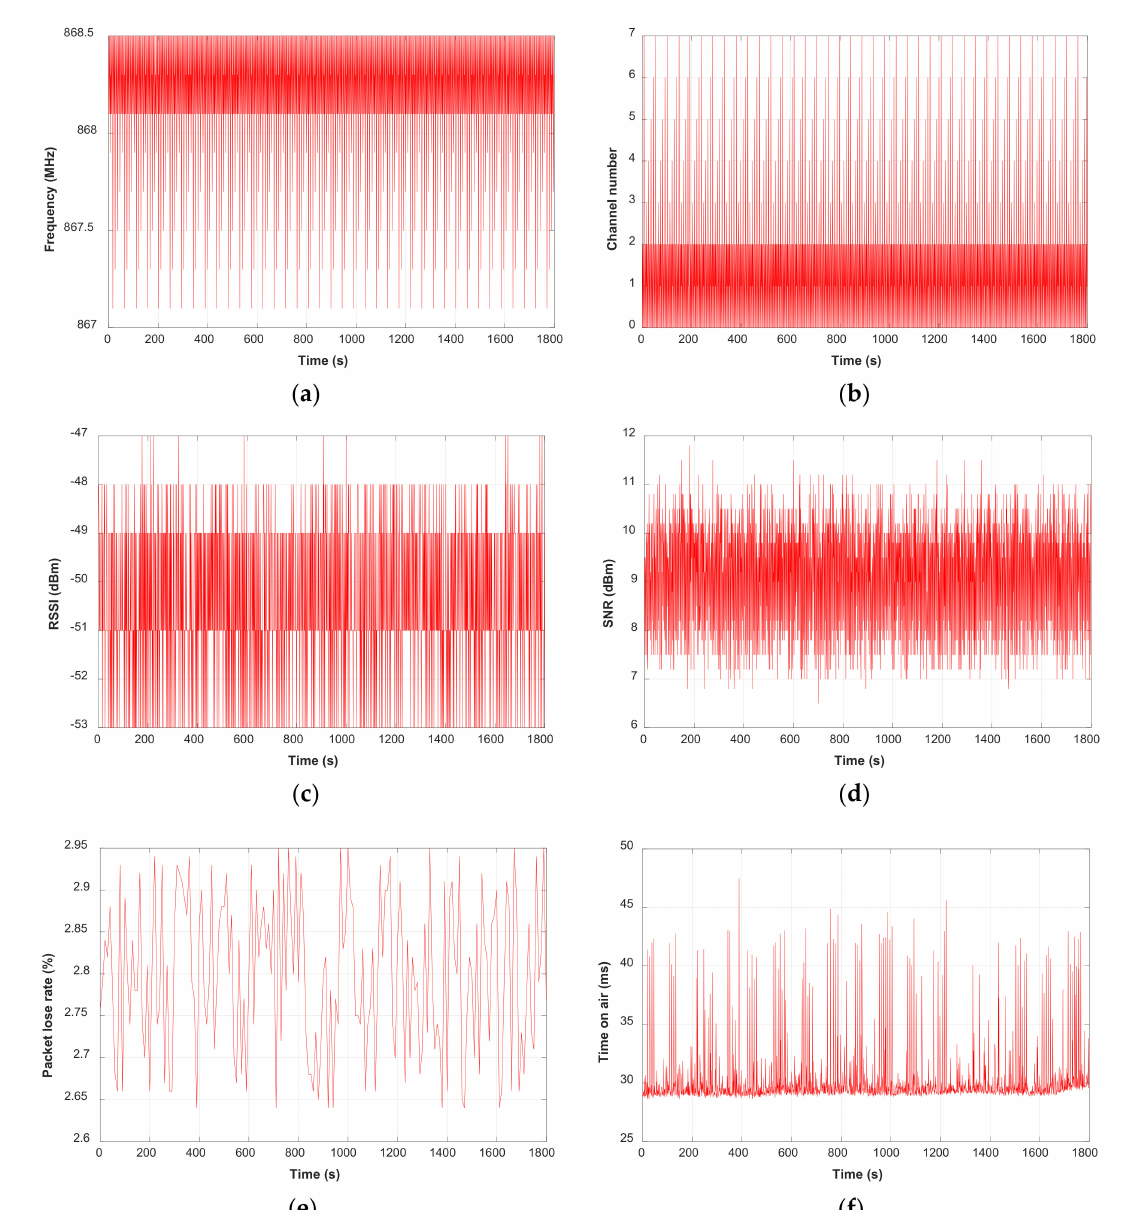
Figure 23. Measurements on the LoRa network: ( a ) frequency; ( b ) channel number; ( c ) RSSI; ( d ) SNR; ( e ) PLR; and ( f ) time on